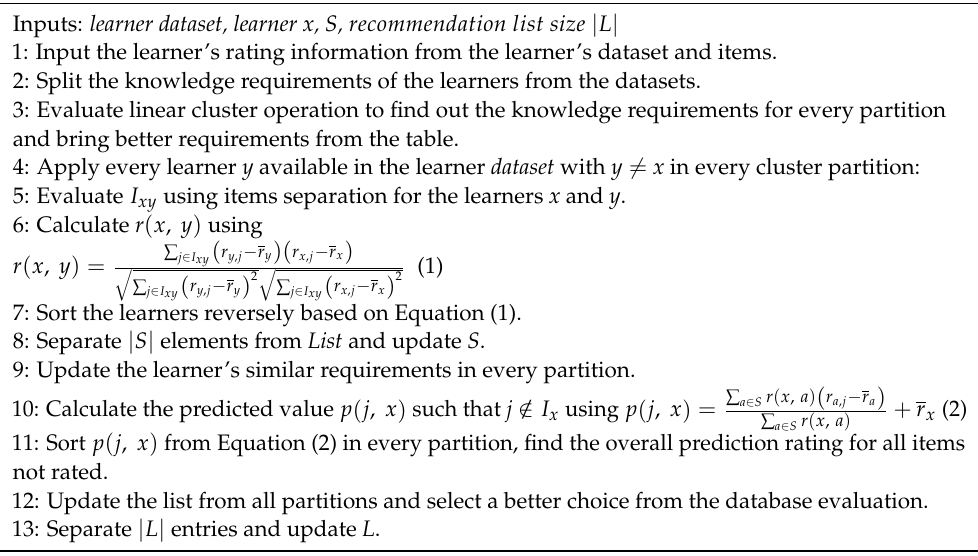
Algorithm 2: New clustered intelligent